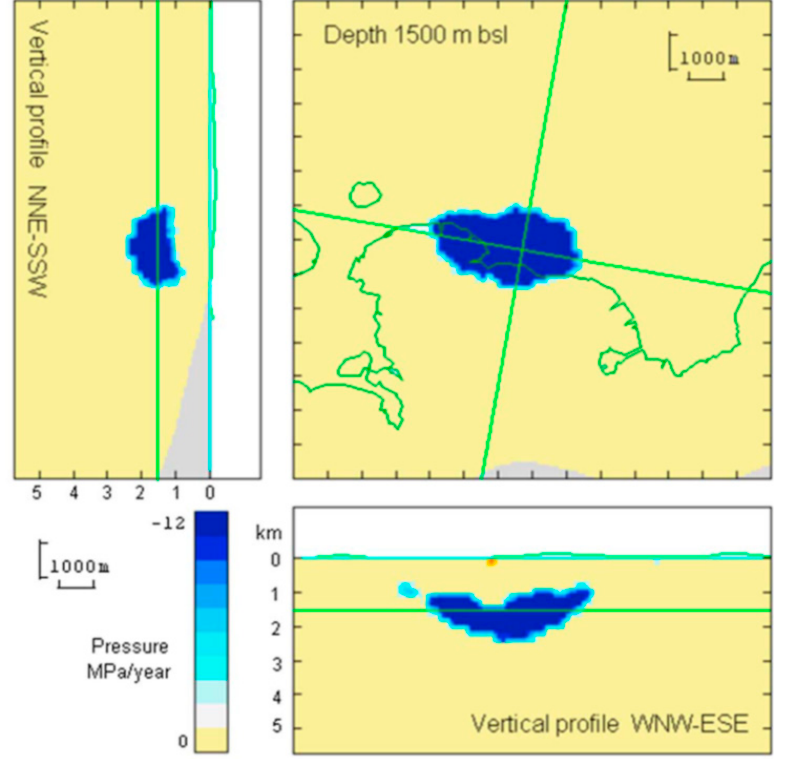
Figure 3. Three cross sections of the 3-D model for depressurization: Horizontal (depth 1500 m) and NNE–SSW and WNW–ESE vertical sections of the under-pressure model across a central position resulting from the simultaneous inversion of the gravity changes, leveling changes, and DInSAR data in Campi Flegrei for 1992–2000 assuming an elastic half-space